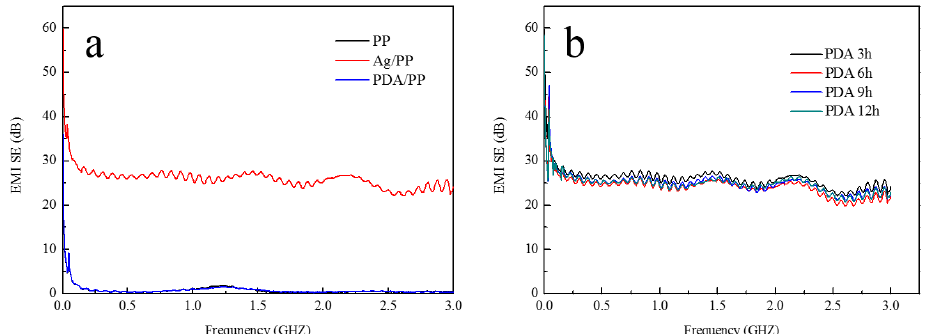
Figure 8. EMI SE of the treated and untreated samples: ( a ) samples before the treatment of dopamine; ( b ) samples after the different treatment time (3, 6, 9, 12 h) of dopamine. ( b ) samples after the di ff erent treatment time (3, 6, 9, 12 h) of